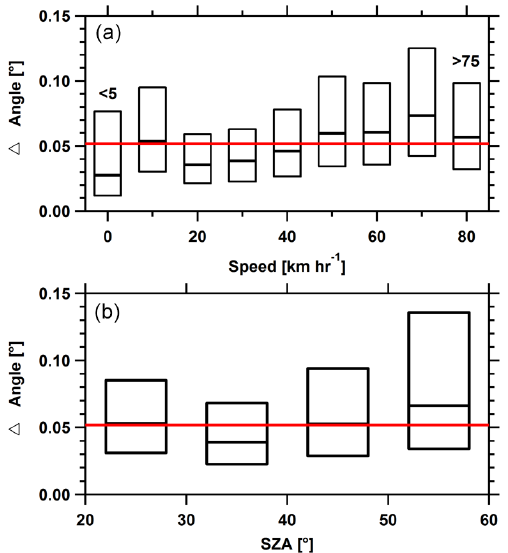
Figure 6. Pointing precision as a function of (a) vehicle speed, and (b) solar zenith angle during the RD 11 on 13 August 2014. The top, center, and bottom of the box represent 75th, 50th (median), and 25th percentiles of the data. The red lines represent the overall 1 σ pointing precision from the Gaussian fits (Fig.